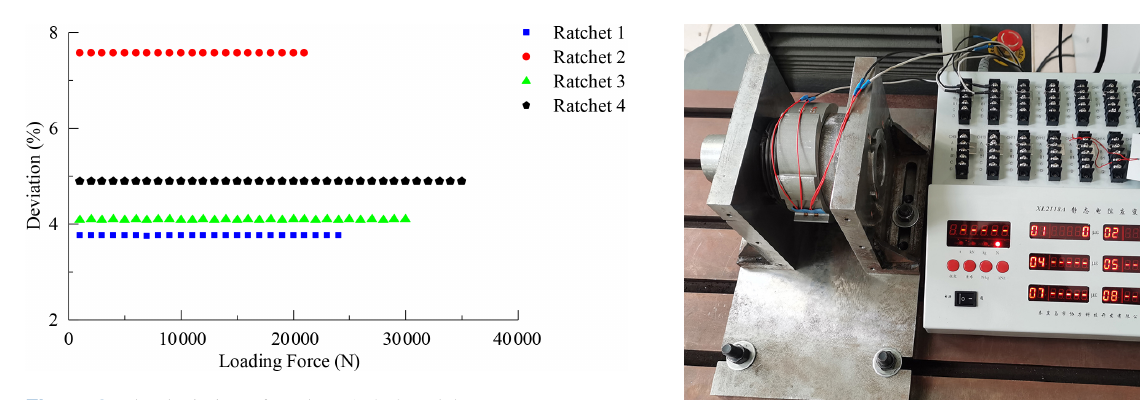
Figure 9. The deviation of ratchets 1, 2, 3 and 4.